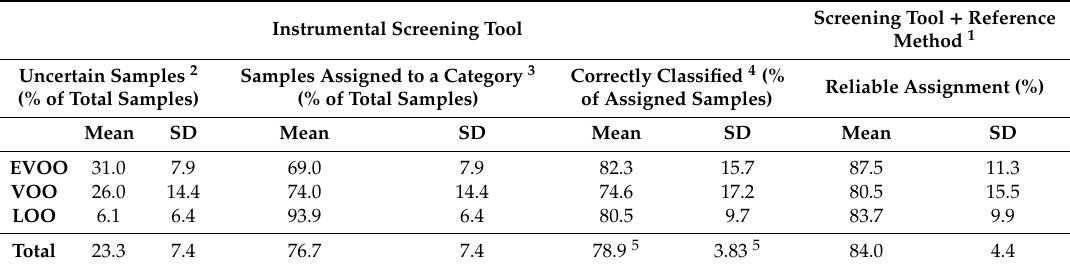
Table 2. External validation results of the instrumental screening tool (classified correctly and uncertain samples for EVOO ( n = 24), VOO ( n = 22) and LOO ( n = 14) samples) and the final reliable assignment considering the screening tool’s plus the panel test’s classification